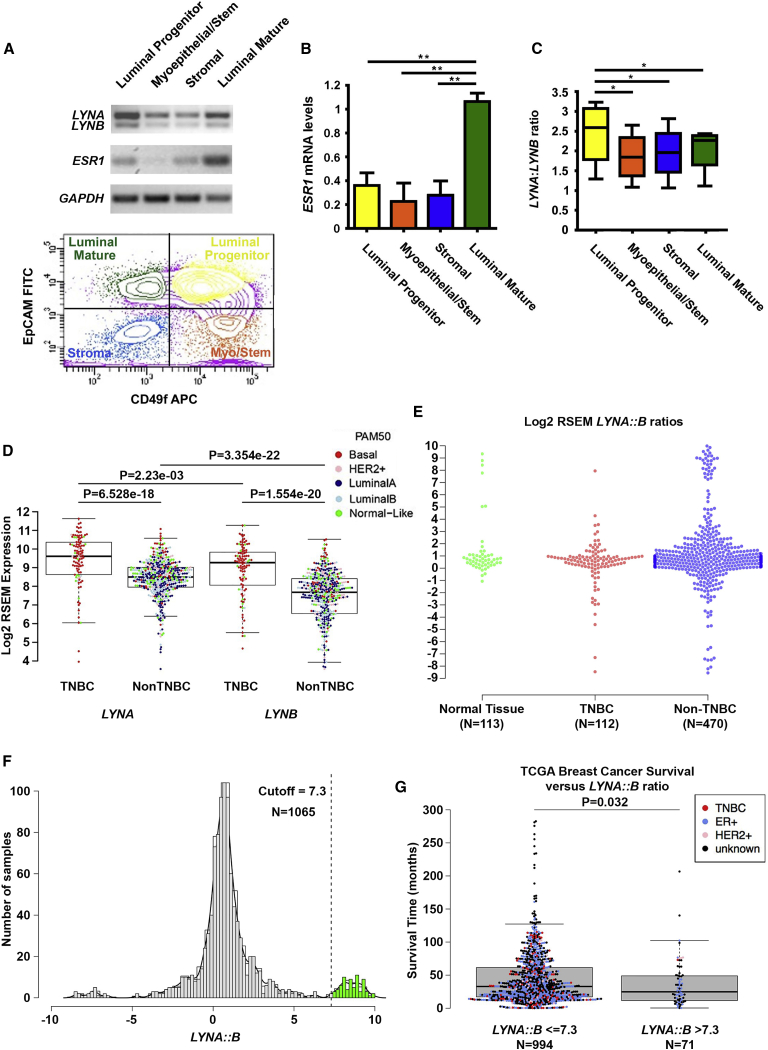
The LYNA::LYNB Isoform Ratio Is Prognostic in Breast Cancer(A) Representative semiquantitative RT-PCR expression analysis of ESR1 and LYN levels in breast cells from reduction mammoplasty tissue separated into stromal cells, basal cells, luminal progenitors, and mature luminal populations (Iriondo et al., 2015). Plot is representative of outcomes of four independent sorts.(B) Quantitation of ESR1 expression levels, confirming ESR1 is most highly expressed in the mature luminal population (mean + SD relative to mature luminal cells; n = 3 independent cell preparations; unpaired two-tailed t test; ∗∗p < 0.01).(C) Quantitation of the relative LYNA::B ratio (n = 4 independent cell preparations; paired two-tailed t test; ∗p < 0.05) in breast cell populations.(D) Expression of LYNA and LYNB isoforms in The Cancer Genome Atlas (TCGA) breast cancer data split by immunohistochemistry (IHC)-defined TNBC (n = 112) and non-TNBC (n = 470) tumors. Tumors are also color-coded based on their PAM50 molecular subtype.(E) For each sample shown in (D), the LYNA::B ratio was established based on log2 expression of LYNA over LYNB. The distribution of LYNA::B ratios among samples derived from normal breast tissue (data also from TCGA), TNBC and non-TNBC were comparable when tested by Wilcoxon rank-sum test.(F) Density distributions of LYNA::B log2 RSEM expression ratios in the TCGA breast cancer dataset. A LYNA::B ratio cutoff of 7.3 is indicated.(G) Breast cancer-specific survival of patients based on LYNA::B isoform expression ratio from TCGA data in patient groups dichotomized at the 7.3 ratio boundary. The IHC phenotype of each tumor (where known) is indicated by the color of each data point. A high LYNA::B ratio selects patients with a shorter survival time independent of the breast cancer subtype (Wilcoxon rank-sum test).See also Figures S9 and S10.